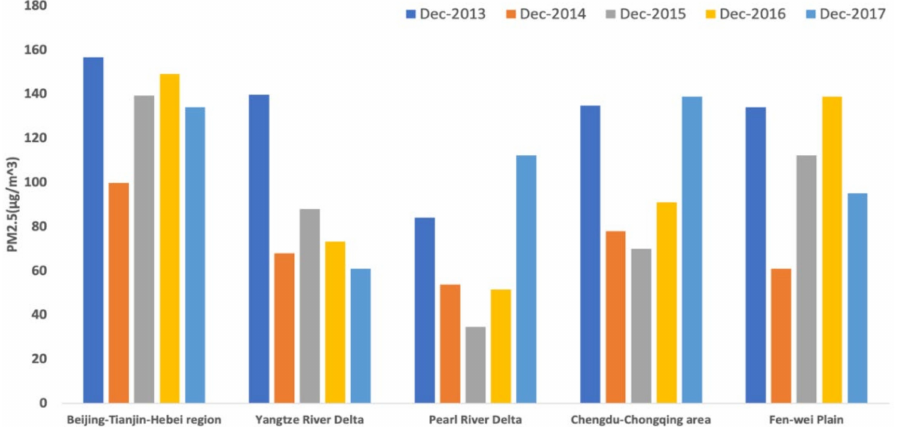
Figure 13. Comparison of PM 2.5 observations in China’s five typical regions in December of